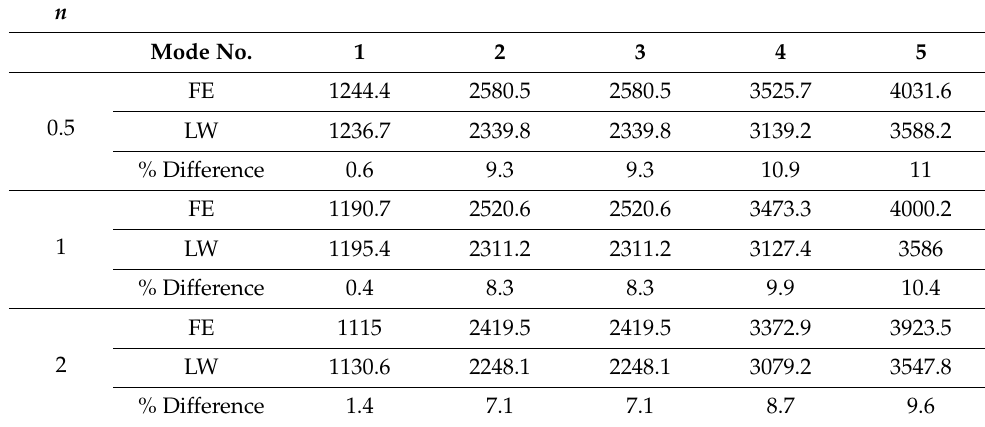
Table 9. Comparison of frequencies (HZ) based on LT and the FE findings for different n .